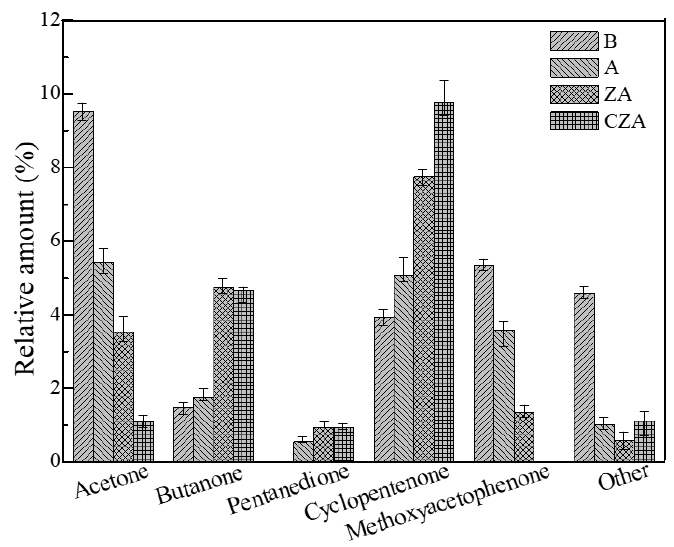
Figure 8. E ff ects of the catalysts on the ketone Figure 8. Effects of the catalysts on the ketone compounds.